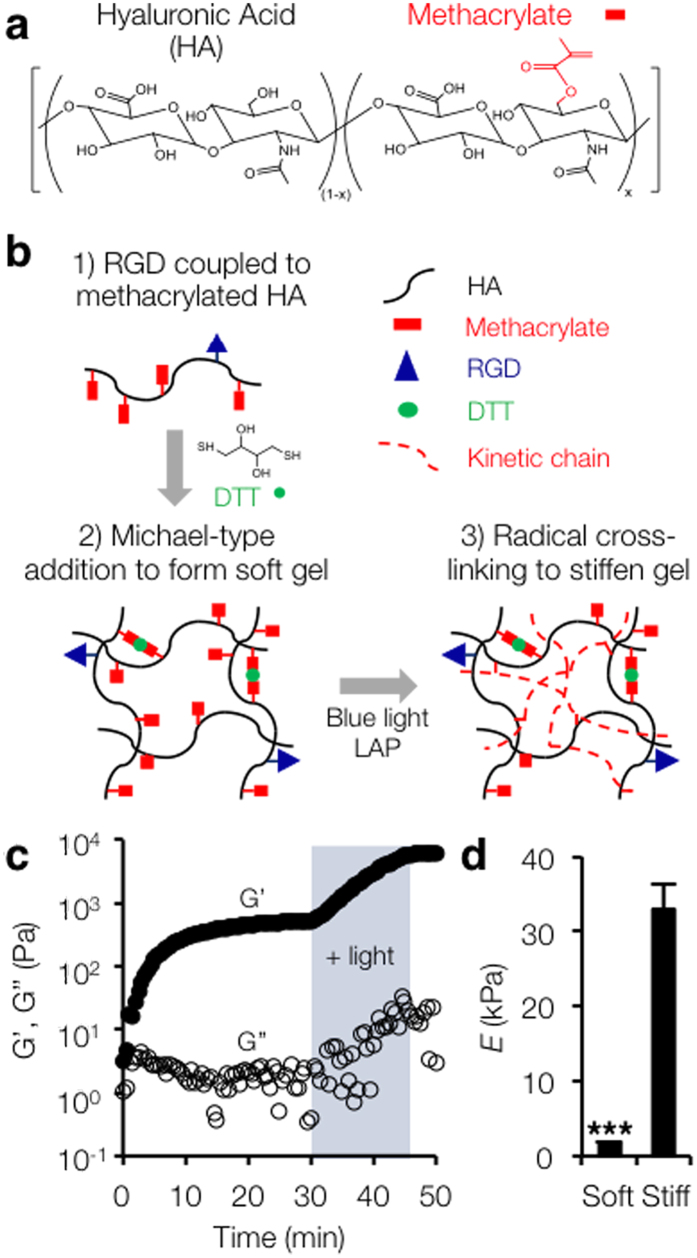
Visible-light mediated stiffening of MeHA gels.(a) Hyaluronic acid was modified with methacrylates to enable both addition and radical crosslinking. (b) RGD-containing peptide was coupled to MeHA followed by an initial Michael-type addition reaction to form a soft gel. Radical polymerization in the presence of visible blue light and the photoinitiator LAP enabled substrate stiffening. (c) Rheology profile showing stiffening of MeHA in response to blue light (3 mW/cm2, 15 min, shaded) in the presence of LAP (6.6 mM). Closed circles represent storage modulus (G’), open circles represent loss modulus (G”). (d) AFM measurements of both soft and stiff (blue light: 10 mW/cm2, 5 min, LAP: 6.6 mM) hydrogel elastic moduli (n = 3 gels per group, error bars represent s.e.m.). ***P < 0.001.